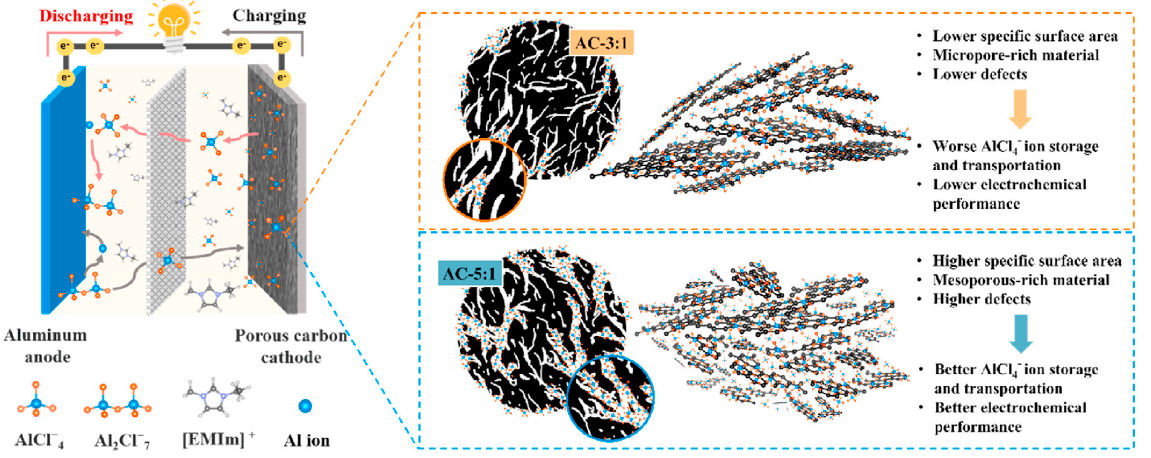
Figure 7. Schematic illustration of AlCl 4 − ion storage by biomass-derived carbon cathodes in a non-aqueous AIB. Reprinted with permission from [76]. Copyright 2022, Elsevier. Table 3. Comparative electrochemical performance of biobased carbon material anodes for Al